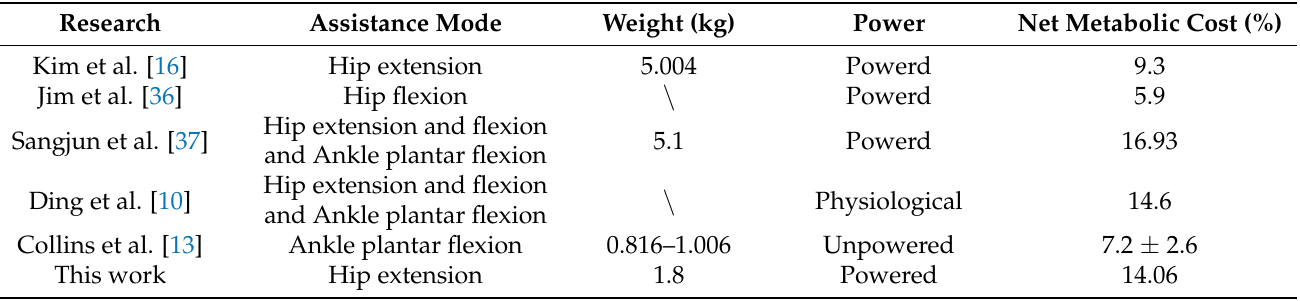
Table 3. Comparison of famous soft